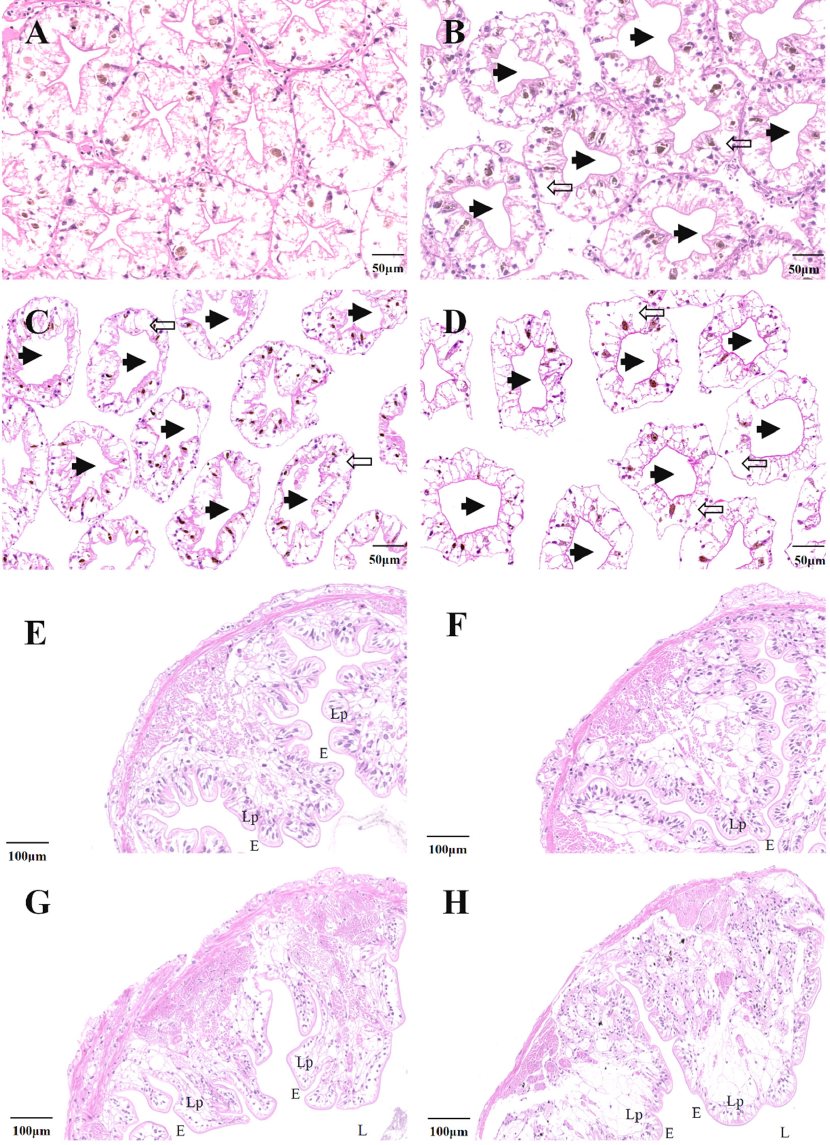
Figure 2. Hg exposure caused hepatopancreas and intestines injury. Hepatopancreas histology from Ctrl ( A ), Low ( B ), Med ( C ), and High ( D ) group in 96 h. Intestines histology from Ctrl ( E ), Low ( F ), Med ( G ), and High ( H ) group in 96 h. Black solid arrow: dilatation of tubule lumen; Black hollow arrow: vacuolization; Lp: lamina propria; E: epithelium; L: lumen. H&E stain (100×). Ctrl: 0 μ g/L Hg 2+ ; Low: 8.75 μ g/L Hg 2+ ; Med: 21.875 μ g/L Hg 2+ ; High: 43.75 μ g/L Hg 2+ .